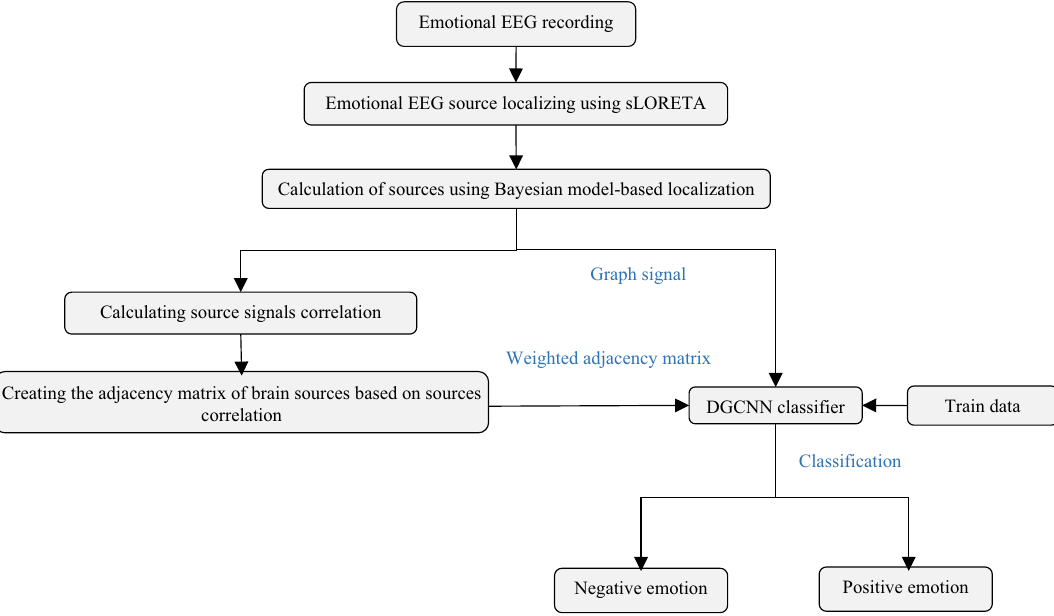
Figure 2. Flowchart of the proposed method (using drawing canvas of Microsoft office word 2016 https:// www. micro soft. com/ en- us/ downl oad/ detai ls. aspx? id= 51791).